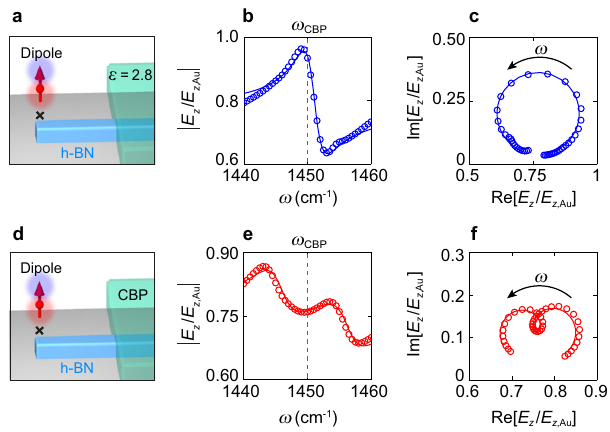
Fig. 3 | Theoretical description of near- fi eld probing of VSC. a Simulation geo- metry, showing a point-dipole source above an h-BN nanorod of 785nm length, 87nmheight and 250nm width, whichishalf covered witha 50nm thicklayer of a permittivity ε = 2.8. b Amplitudeof the z -component of the electric fi eldbelowthe dipoleatthepositionmarkedbyacrossinpanel a (normalizedtothatobtainedon aAureferencesurface, ∣ E z = E z,Au ∣ ),asfunctionoffrequency ω . c z -componentofthe electric fi eld below the dipole source at the position marked by a cross in panel a , plotted in the complex plane. The arrow indicates increasing frequency ω . d Simulation geometry, showing a point-dipole source above the same h-BN nanorod asin panel a but half covered with CBP molecules. e Same aspanel b , but the h-BNnanorodishalfcovered bya50nmthickCBPlayer. f Same as panel c ,but for a half CBP-covered h-BN nanorod. b , c , e , f Open symbols show simulation results. Solid lines show fi ts obtained with b , c a single harmonic oscillator model and e , f a coupled harmonic oscillator model describing the coupling between the nanoresonator modes and the molecular